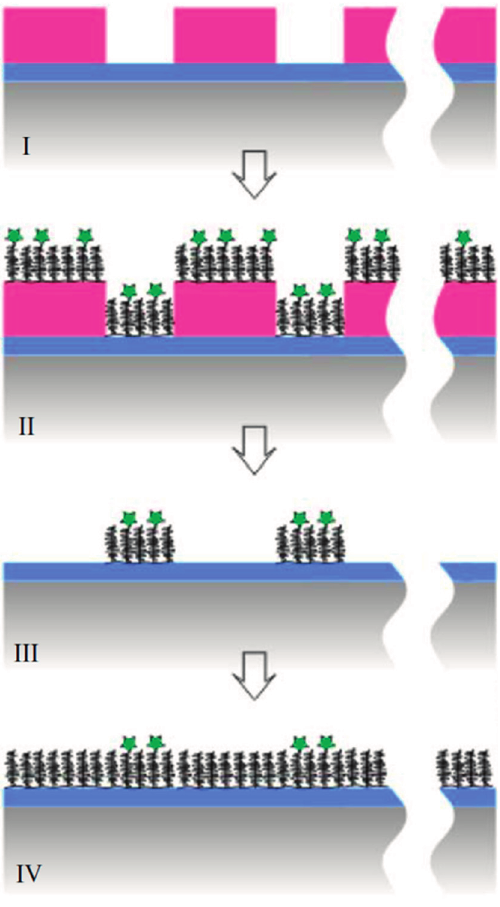
Figure 9. Schematic of the MAPL process, showing how it can be used to convert a photoresist patterned oxide substrate into a surface with well-controlled biointeractive patches in a non-interactive background [122]. The sample composed of a photoresist pattern (stage I ) is dipped into a solution of functionalized (e.g., biotin or RGD) PLL- g -PEG (stage II ). The functionalized PLL- g -PEG adsorbs strongly to the bare oxide surface. Next, the PR is removed with an organic solvent without altering or desorbing the polymer immobilized on the oxide, but lifts off polymer on top of the resist (stage III ). Finally, the sample is incubated in a solution of nonfunctionalized PLL- g -PEG to render the background resistant to the adsorption of biomolecules (stage IV